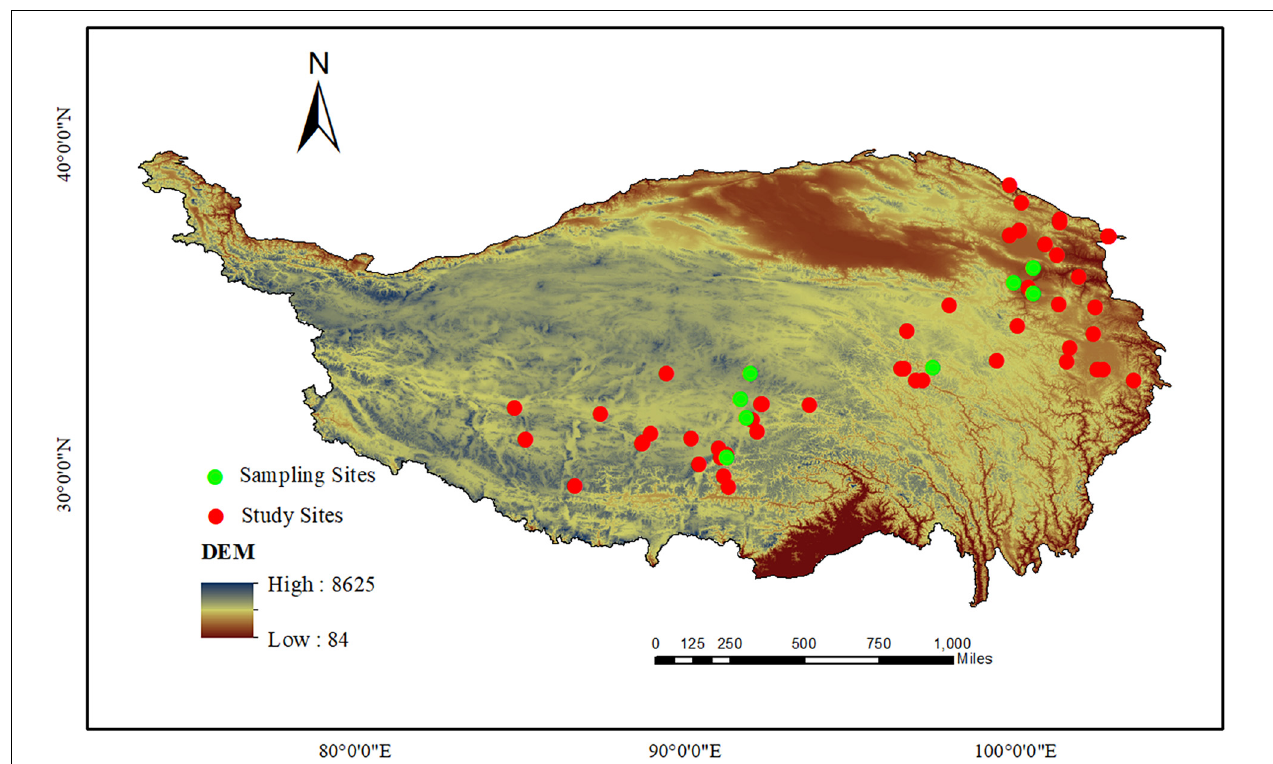
FIGURE 1 | Distribution of sample sites of the data sets included in this